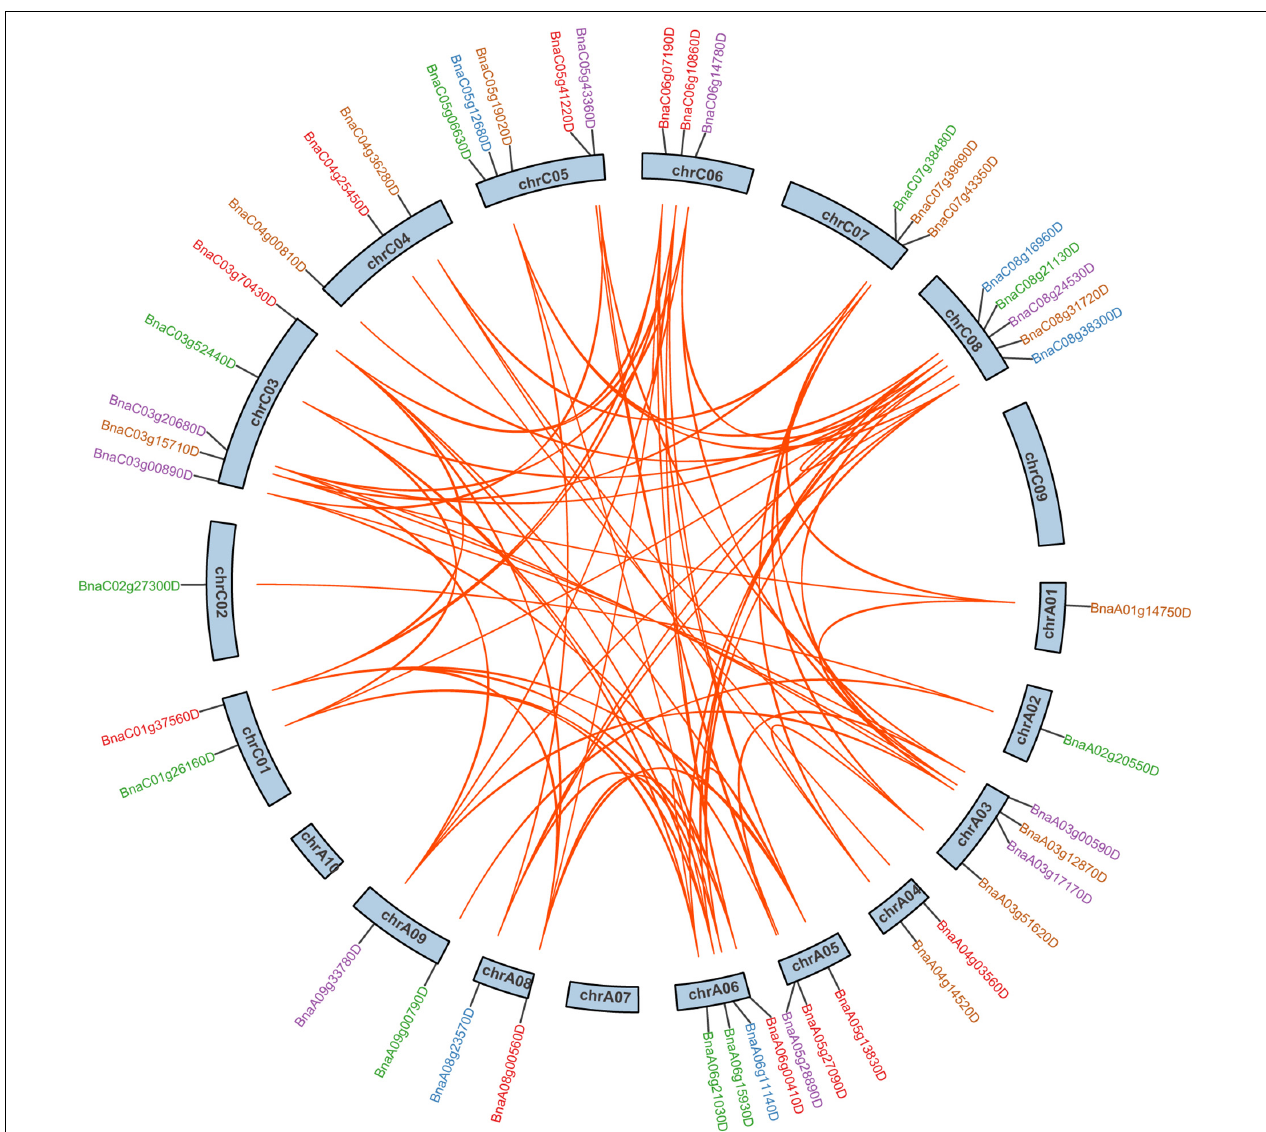
FIGURE 2 | The chromosomal distribution and duplication analysis of SR genes in B. napus . The locations of all the chromosomal SR genes were shown in different chromosomes. The different colors indicated different subfamilies of the SR genes. The orange lines highlighted the duplicated SR gene